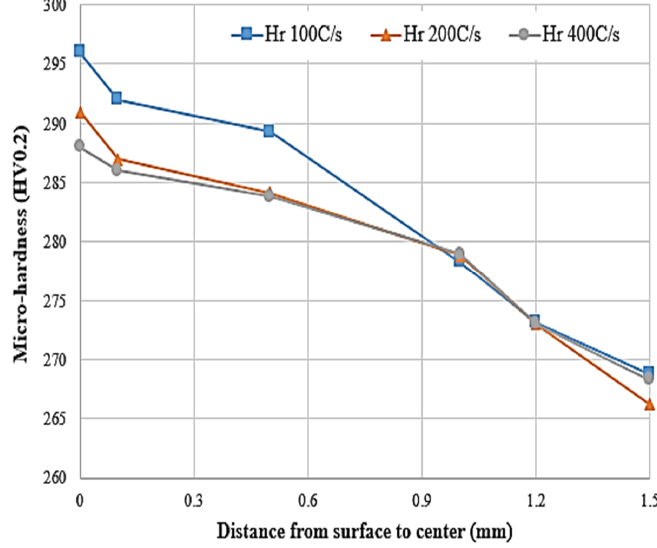
Figure 15. Hardness distribution curves of the SLMed IN718, from the surface to the center of the sample for different heating rates in area showed in Figure 7.